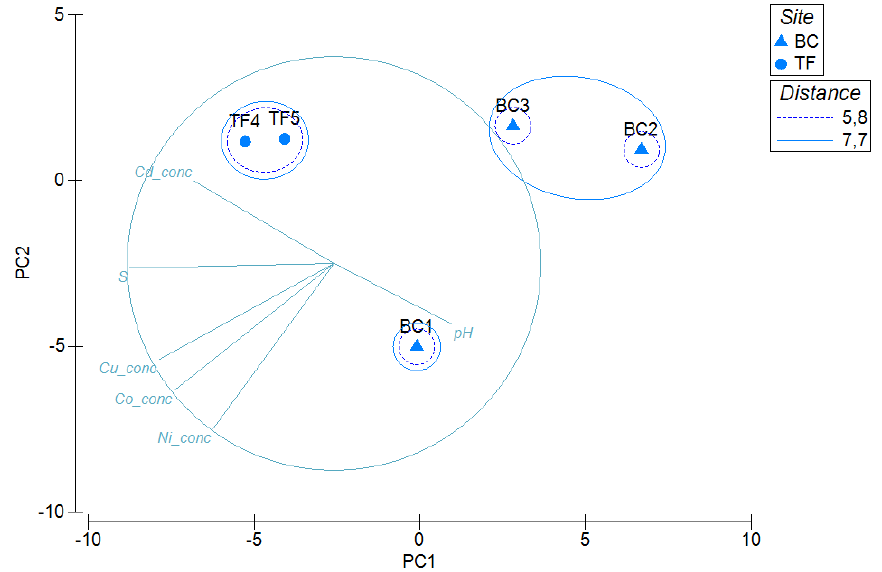
Figure 6. Non-metrical multidimensional scaling (nMDS) analysis (Bray-Curtis similarity matrix) computed on the entire phenotypic data set, evidencing connections with the phylogenetic affiliation of isolates.